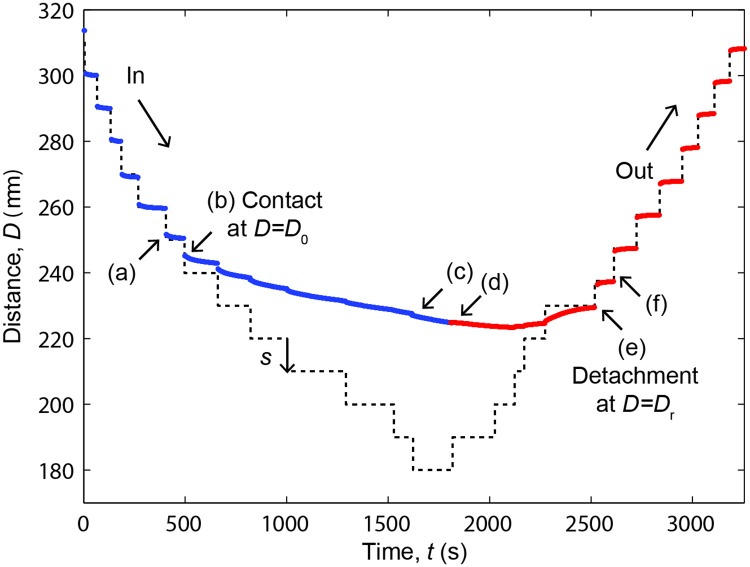
Transient viscous response to a step-wise compression-decompression cycle.D is the distance between the silver surfaces (continuous line) in response to step displacements of the cantilever spring with length s = 10 μm (dashed line). The surfaces were first approached (‘in’–blue line) then retracted (‘out’–red line). The thickness of the corneal stroma was D0 before compression and Dr after completely removing the compressive force. Arrows show: (A) last step before surface contact; (B, C) increasing compression with both surfaces in contact with the sample; (D) first step of surface retraction/decompression; (E) surface detachment upon retraction; (F) first step after detachment.